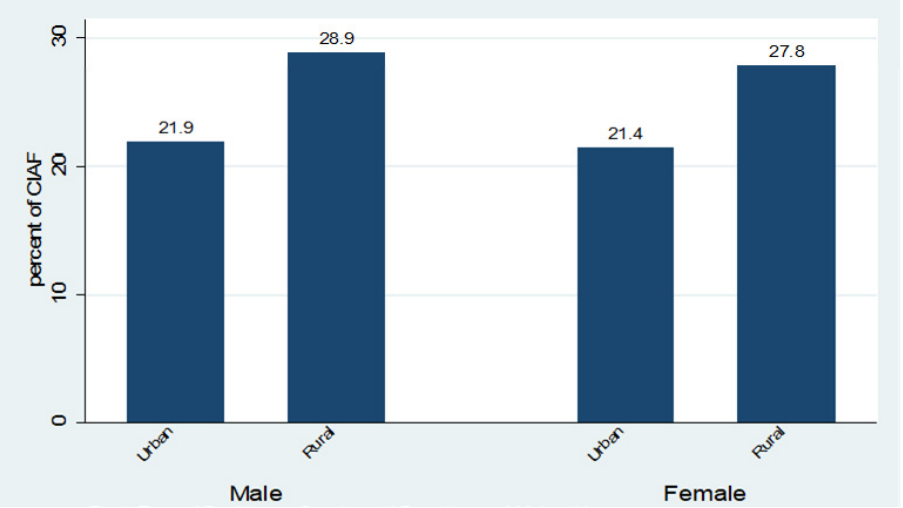
Figure 1. Type of Residence, Gender and Prevelance of Malnutrition.